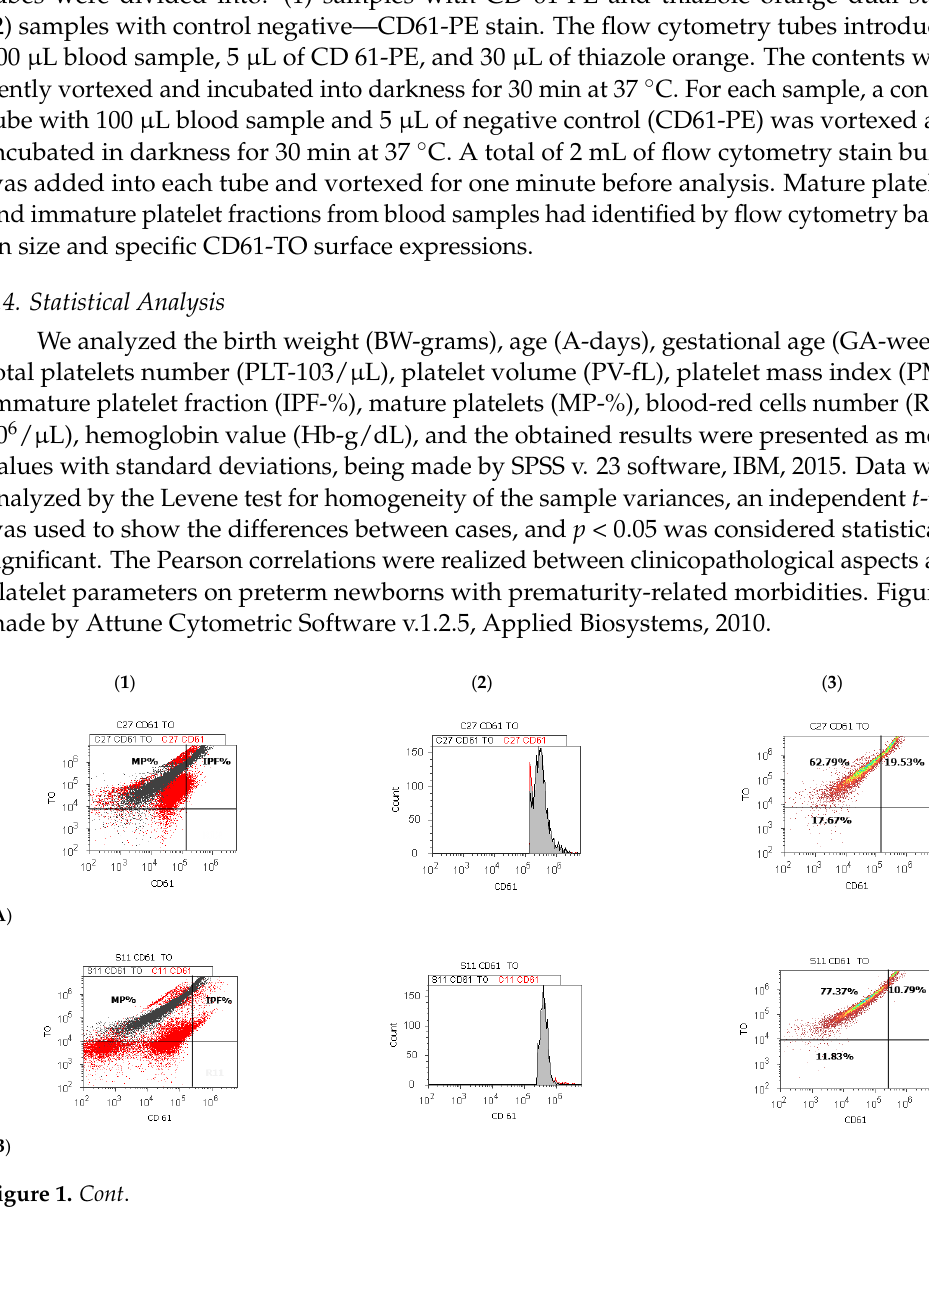
Figure 1. Blood-cell analysis of the immature platelet fraction (IPF) by CD 61 platelet membrane glycoproteins and thiazole orange stain (TO), performed by the Attune Acoustic focusing cytometer, Life Technologies, the USA, equipped with the Attune Cytometric Software v.1.2.5, Applied Biosys- tems, 2010. ( A ) Healthy full-term newborn with normal IPF; ( B ) Preterm newborn with respiratory distress syndrome with the need for respiratory support (RDS+) and intraventricular bleeding (IVH+) with low IPF; ( C ) Preterm newborn with anemia of prematurity (AoP+) with low IPF; ( D ) Preterm newborn with respiratory distress syndrome with the need for respiratory support (RDS+) with low IPF; ( 1 ) Dot plot by control extrapolation (CD61) on graphic; ( 2 ) Histogram plot by IPF% extrapolating on CD61 axis; ( 3 ) Density plot with quantification of immature platelet fraction (IPF%) and mature platelets (MP%) by highlighting the double-positive stained platelets population represented by IPF. 3. Results 3.1. Platelet Parameters at Preterm Newborns Reported to Healthy Full-Term Newborns Cases The descriptive statistic of mean values of clinicopathological aspects and platelet parameters at preterm newborn (experimental-E) and healthy full-term newborn (control- C) cases are presented in Table 1. The birth weight of preterm newborns had significantly lower values than a healthy full-term newborn (E-1433.57 ± 467.77 g vs. C-3316.66 ± 440.67 g,